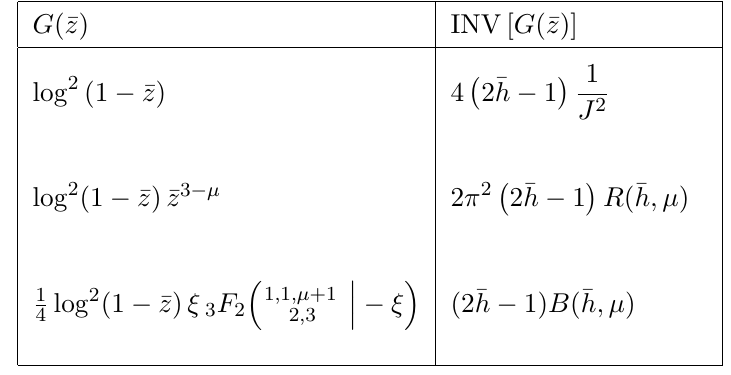
Table 3 . Inversions for G ((cid:22) z ) not containing non-integer powers of (1 (cid:0) (cid:22) z ). G ((cid:22) z ) INV [ G ((cid:22) z )]